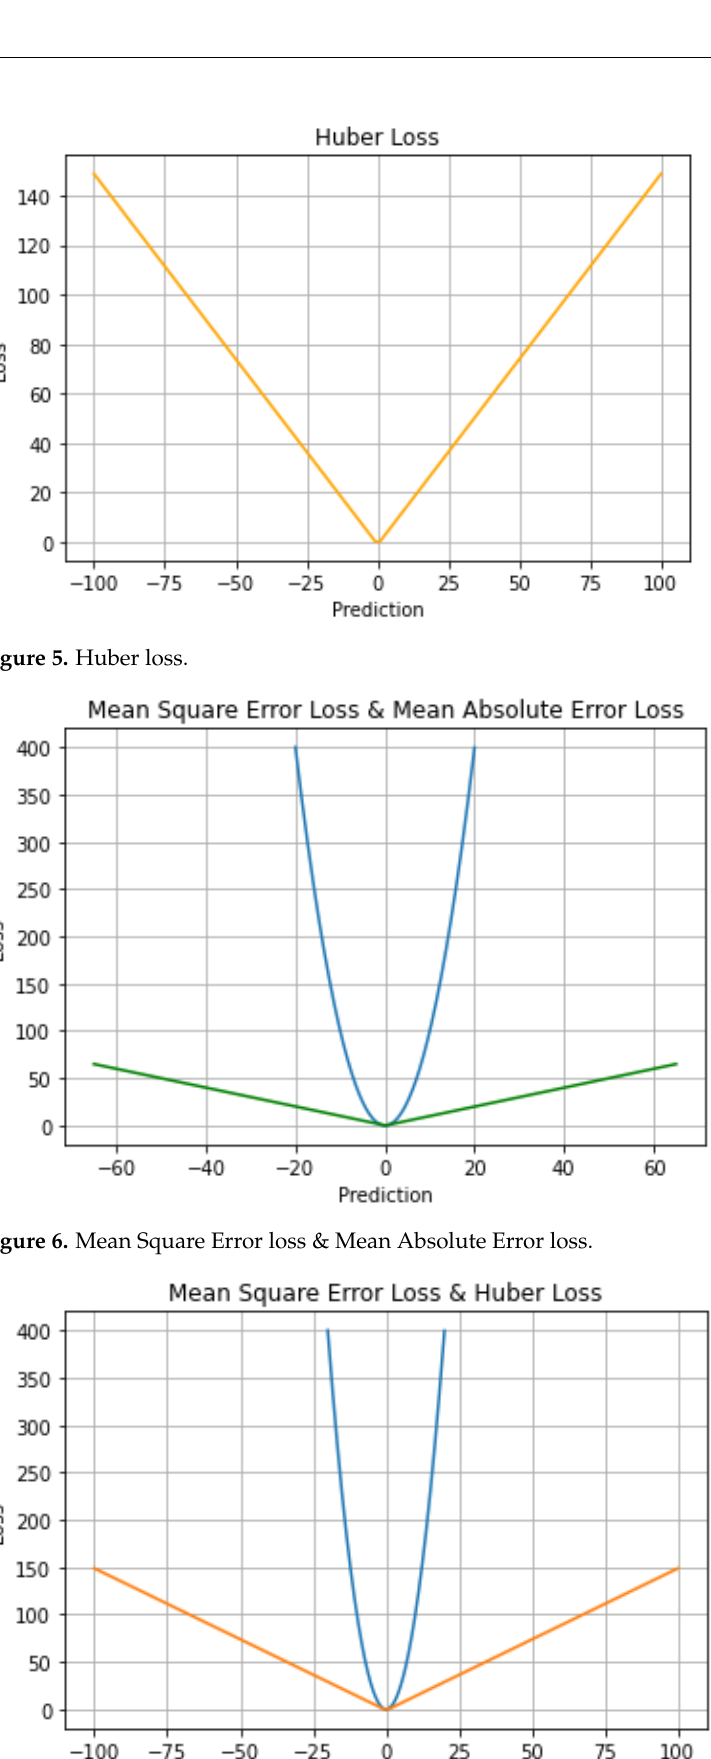
Figure 8. Mean Absolute Error loss & Huber loss.